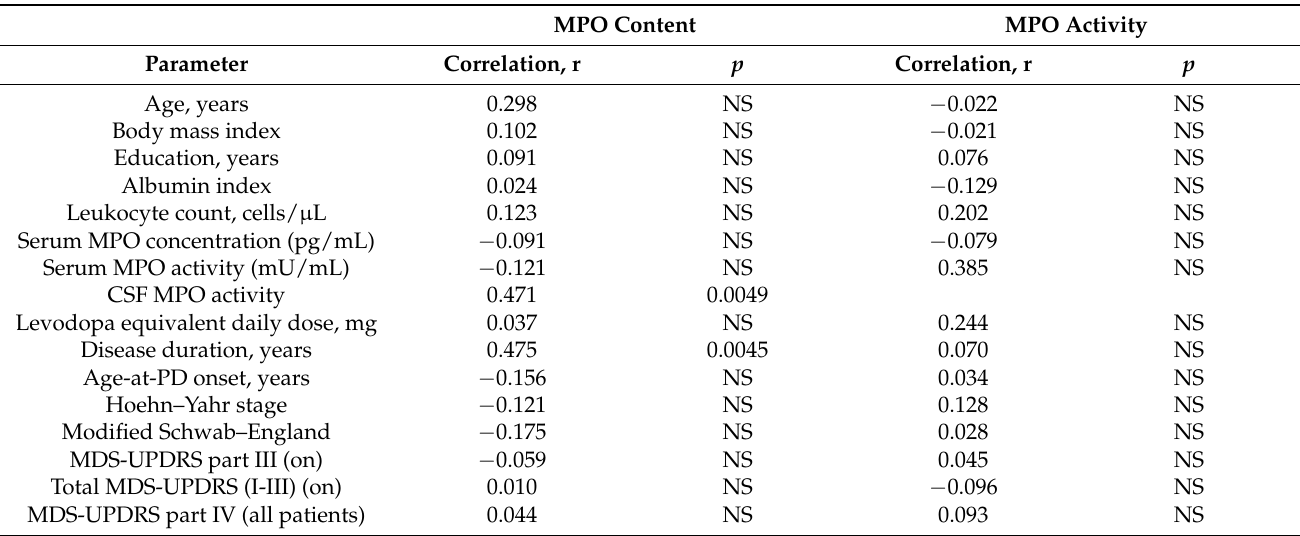
Table 2. Correlation of MPO concentration and activity in the CSF with demographic and clinical parameters in the cohort of patients with idiopathic Parkinson’s